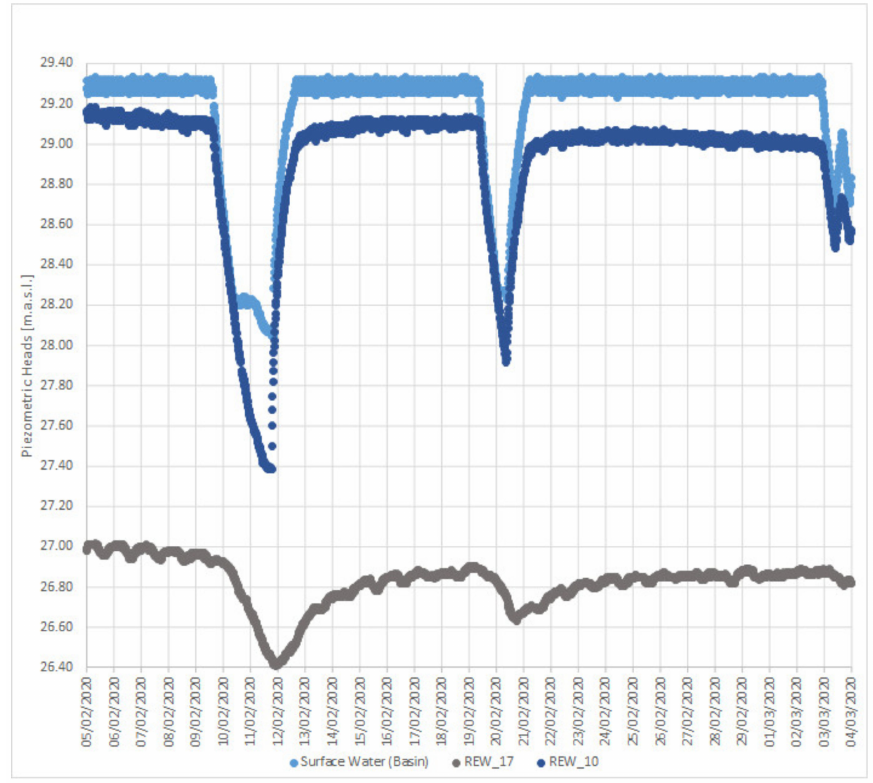
Figure 6. Recorded piezometric heads from in-situ sensors (m above mean sea level).